Question: In one sentence, what is this figure communicating?
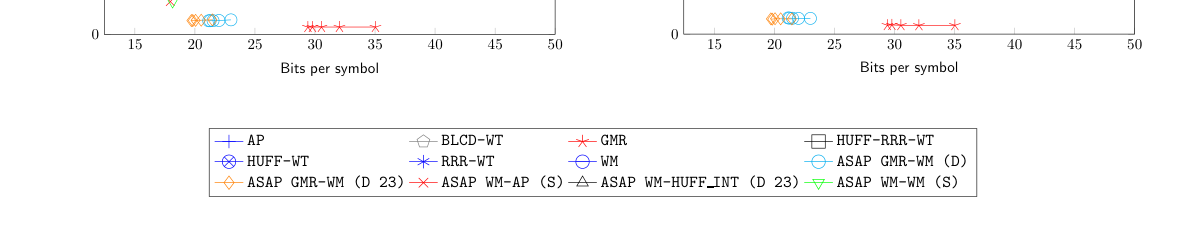
Answer: Experimental results for operations rank (above) and select (below) on the Wikipedia text. The x axis shows the space usage in bits per symbol and starts at H0(s) = 12.45 bits. The y axis shows the average operation time, in microseconds per operation.